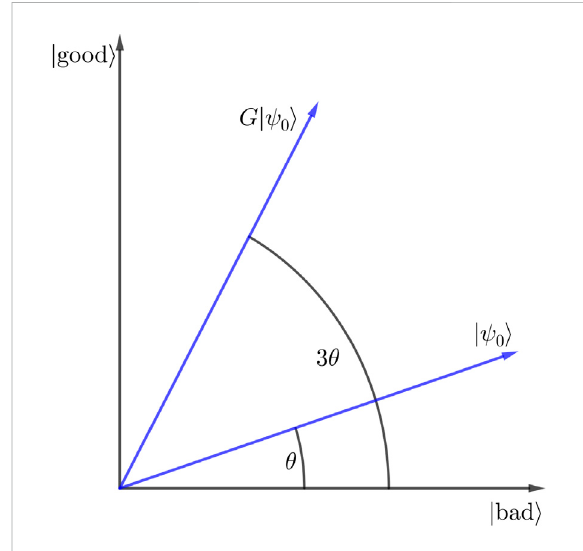
FIGURE 2 Effect of one Grover iteration used in quantum amplitude ampli fi cation. The axes represent the components of | ψ 0 〉 in the “ good ” subspace and in the complementary “ bad ”